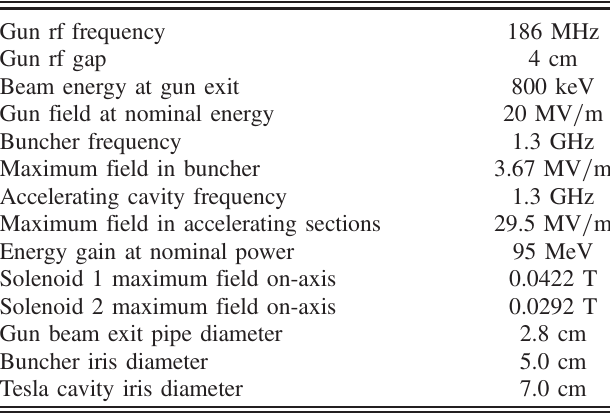
TABLE I. The parameters of the beam line components relevant to these studies.